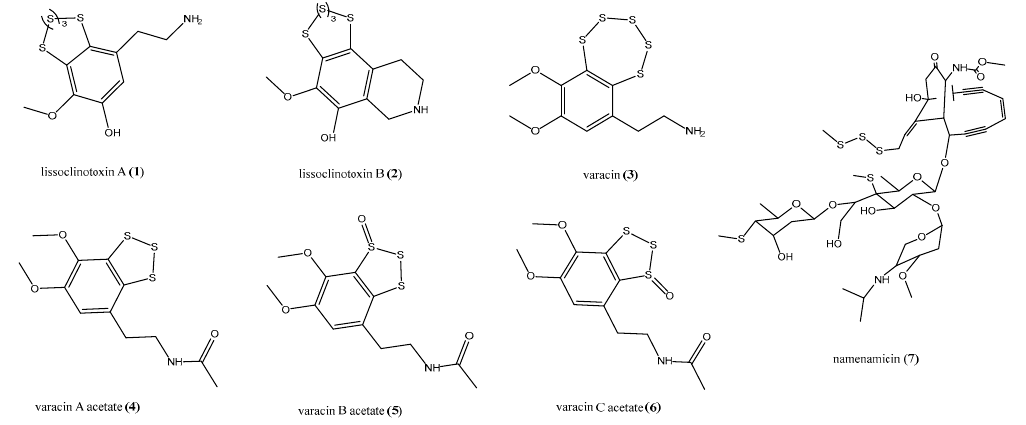
Figure 2. Structures of the antimicrobial polysulfides lissoclinotoxins ( 1 – 2 ), varacins ( 3 – 6 ), and namenamicin ( 7 ).